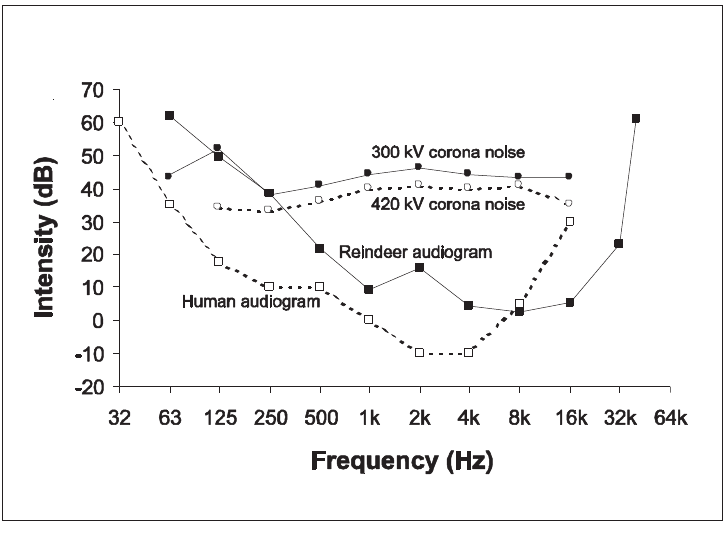
Audiogram of reindeer (Flydal et al. , 2001) and man (Fay, 1988), and measurements of noise from 300 kV and 420 kV power lines measured directly underneath the power lines (see